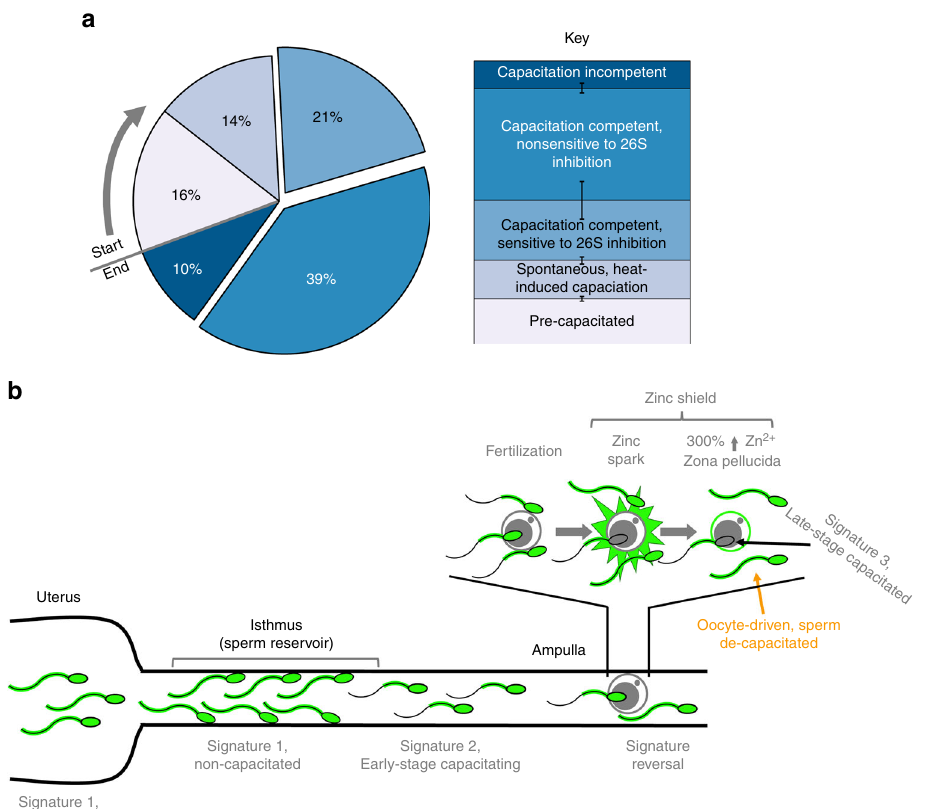
Fig. 6 Proposed zinc signature population interpretation. a Interpretation of zinc signature meaning and population segregation: 16% of fresh, ejaculated spermatozoa had undergone early-stage capacitation upon semen collection (lightest blue working to darkest); 14% of spermatozoa spontaneously undergo early-stage capacitation during incubation without IVC inducers; 60% of spermatozoa remained capacitation competent with IVC inducers, with 21% sensitive to proteasomal inhibition; remaining 10% of sperm were capacitation incompetent under IVC conditions (darkest blue) (s.e. bars included).